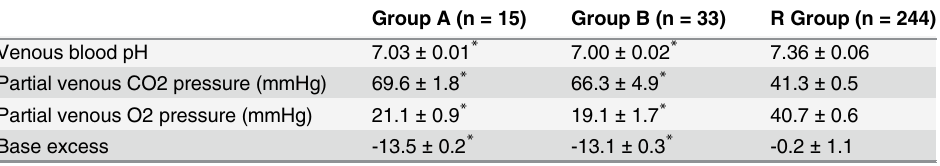
Table 2. Laboratory parameters recorded at birth in asphyxiated newborns with normal (Group A) or abnormal (Group B) neurological outcome and in healthy subjects (Reference Group, R Group).